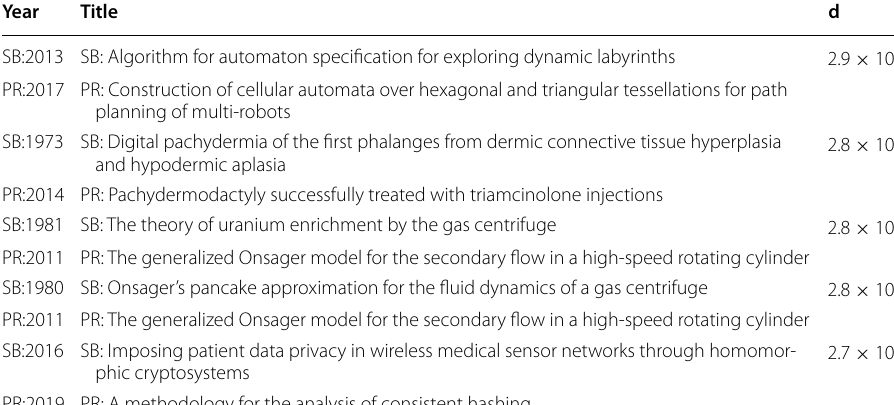
Table 11 Top 5 SB–PR pairs with the lowest d Year Title SB:1972 SB: A double sampling scheme for estimating from misclassified multinomial data with applications to sampling inspection PR:2004 PR: Increasing power for tests of genetic association in the presence of phenotype and/or genotype error by use of double-sampling SB:1977 SB: Evolution and tinkering